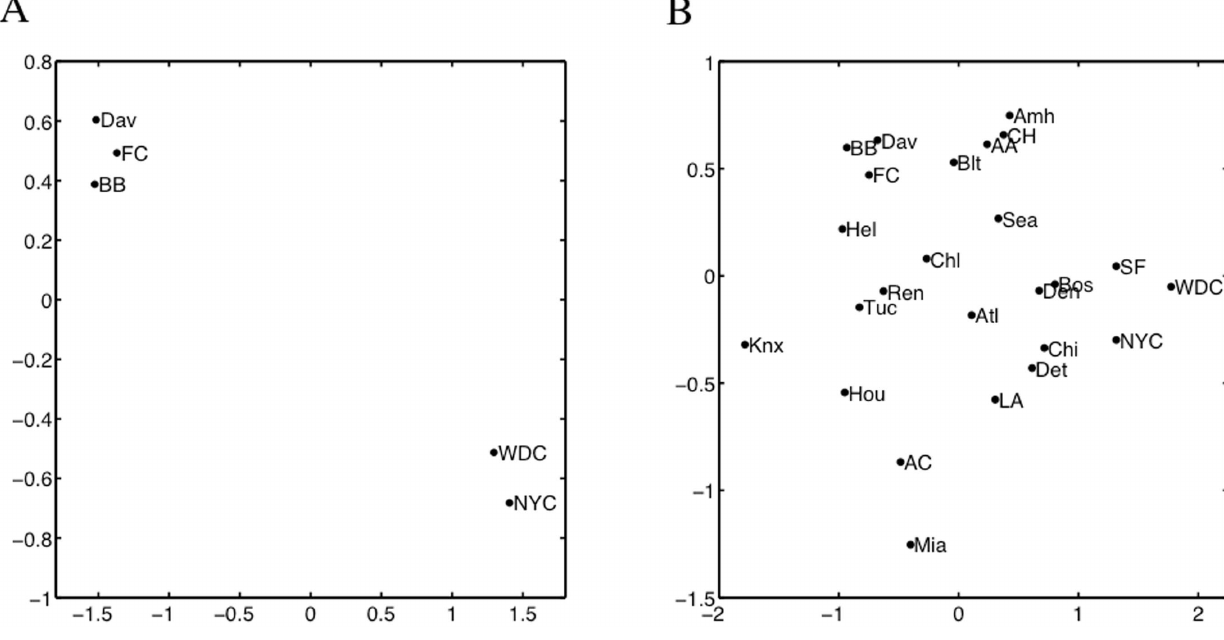
Figure 7. New cognitive feedback and updated view of city-data. Figure A plots another example of cognitive feedback that groups college towns separately from large cities. Figure B plots an updated visualization of the data that accounted for the feedback in Figure A.